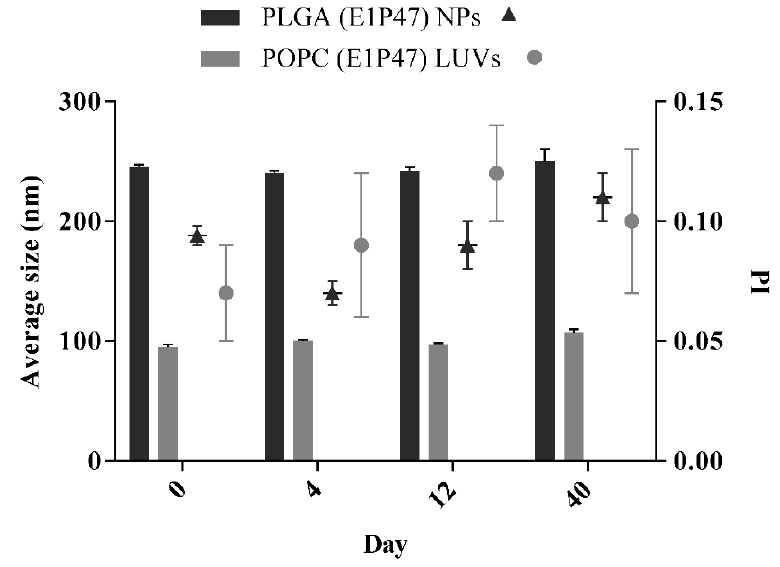
Figure 1. Short-term stability of PLGA (E1P47) NPs and POPC (E1P47) LUVs. Bars correspond to average size measurements and are referred to the left side of the Y axis. Symbols correspond to polydispersity index (PI) results and are referred to the right side of the Y axis. Values are expressed as mean ± SD. (Z av and PI stored at 4 °C; n = 3).